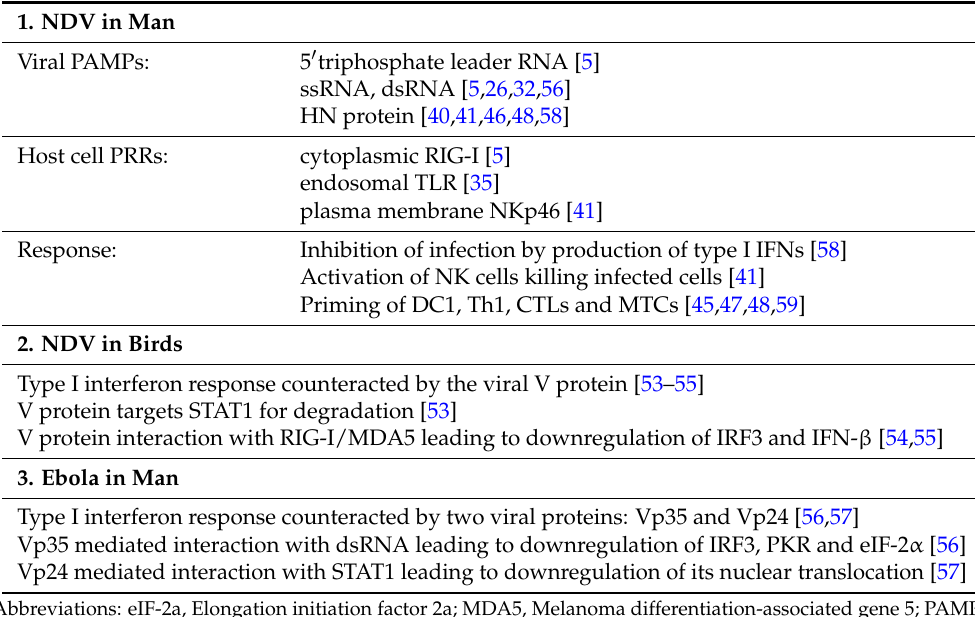
Table 1. Examples of molecular determinants for RNA viral immune stimulation and for RNA viral immune escape for NDV and Ebola